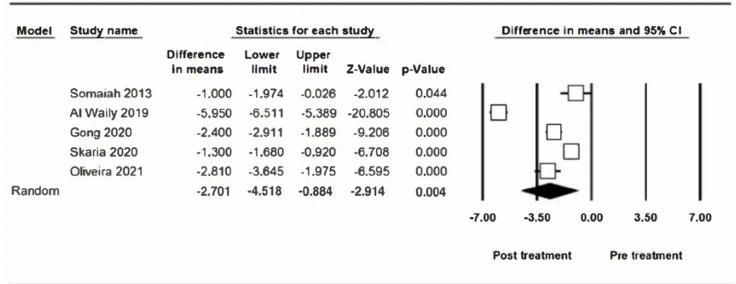
Figure 4. Reduction in gummy smile at three months.